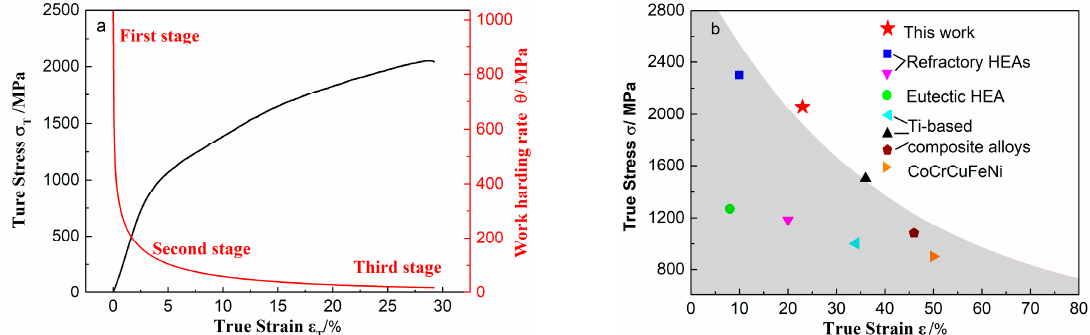
Figure 2. ( a ) The work hardening rate and true stress versus true strain curves engineering stress- strain curve of Φ 3 mm Ti 40 Ni 40 Cu 20 alloy; ( b ) compressive properties compared to some other advanced alloys.